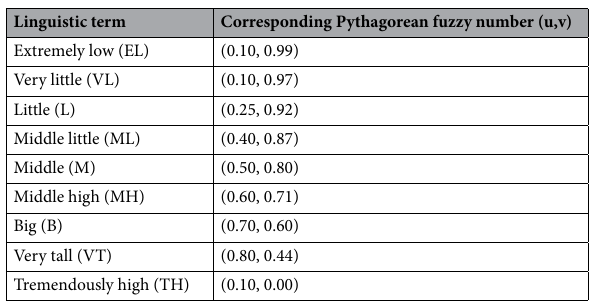
Table 7. Pythagorean fuzzy linguistic scale used in PFTOPSIS.